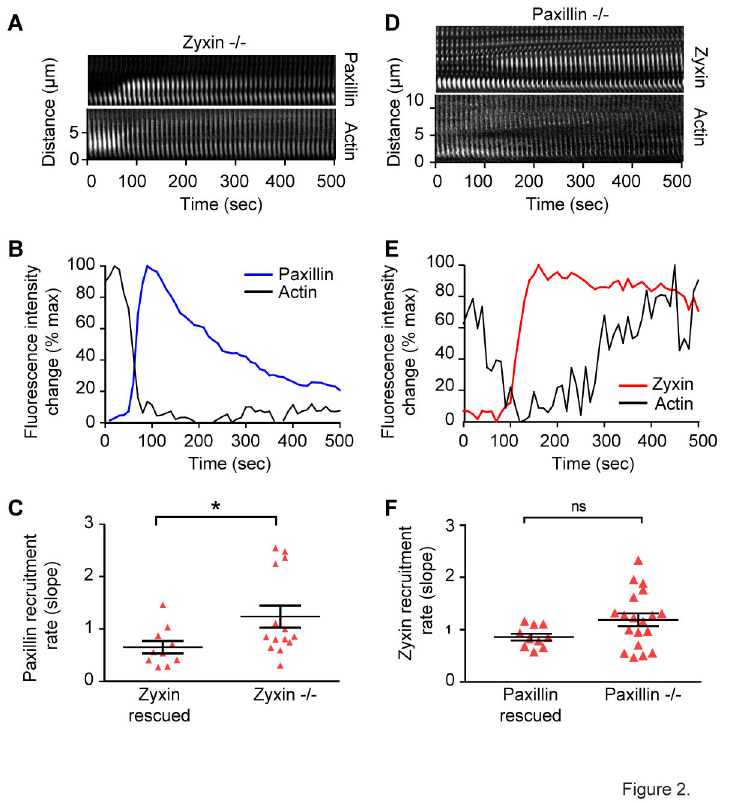
Figure 2. Paxillin and zyxin do not require the other for recruitment to stress fiber strain sites. Kymograph (A) and average intensity plot (B) of paxillin-GFP recruitment and actin thinning at stress fiber strain sites in zyxin-/- fibroblasts showing paxillin recruitment in the absence of zyxin. The rate of paxillin recruitment at strain sites (C) is faster in cells lacking zyxin when compared to zyxin rescued cells. Kymograph (D) and intensity plot (E) of zyxin-GFP recruitment and actin thinning at stress fiber strain sites in paxillin-/- fibroblasts showing zyxin recruitment occurs in the absence of paxillin. The rate of zyxin recruitment (F) is not significantly different in paxillin-/- cells when compared to paxillin rescued